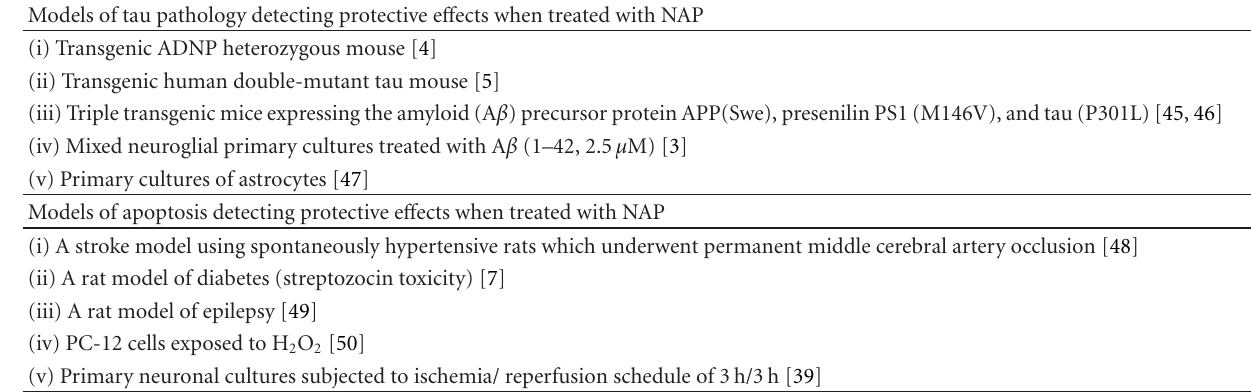
Table 1: Models of NAP protection against tau pathology or increased markers of apoptosis. Models of tau pathology detecting protective e ff ects when treated with